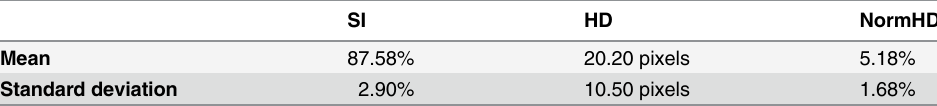
Table 2. Means and standard deviations for SI, HD and